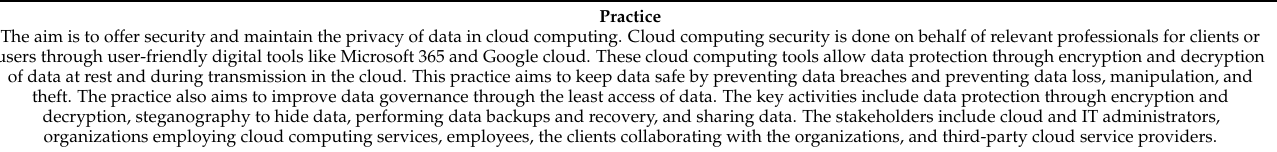
Table A1. Showing the Design Science Research